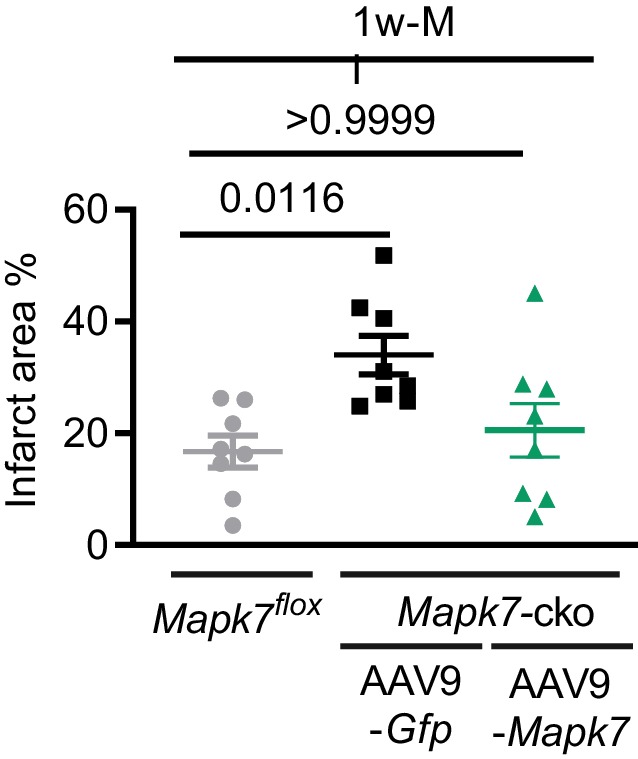
Infarct area comparison between Mapk7flox and Mapk7-cko injected with AAV9-Mapk7 seven days after MI.Infarct area detected by triphenyltetrazolium chloride (TTC) staining in (N = 8 mice). Mapk7flox and Mapk7-cko mice with control injection and Mapk7-cko mice with AAV9-Mapk7 injection one week post-MI. Scale bar: 1 mm.Figure 5—figure supplement 2—source data 1.Infarct area comparison between Mapk7flox and Mapk7-cko injected with AAV9-Mapk7 seven days after MI.